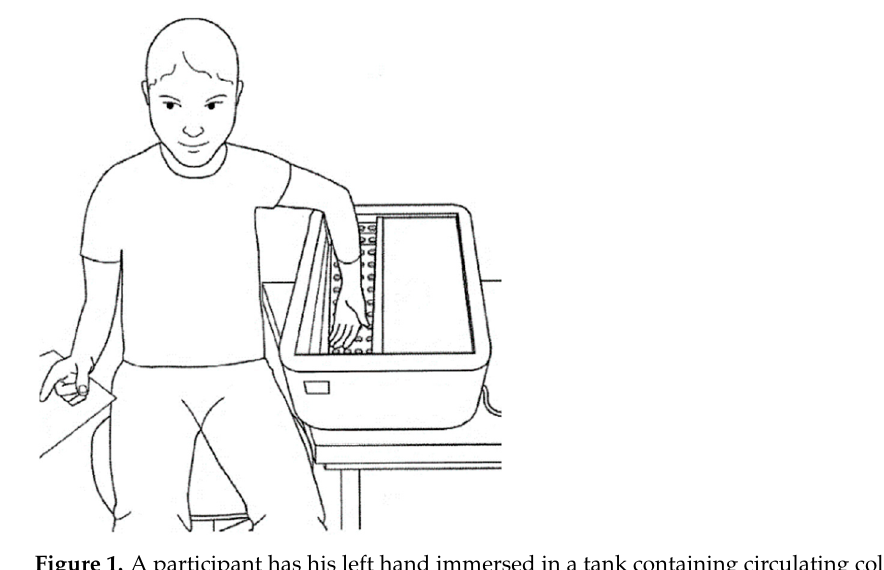
Figure 1. A participant has his left hand immersed in a tank containing circulating cold water.